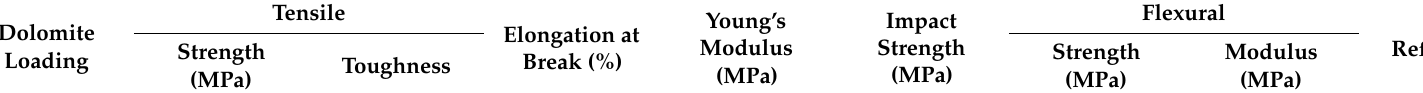
Table 4. Summary of literature studies reporting the type, processing methods, and properties of polymer composites with physically modified dolomite